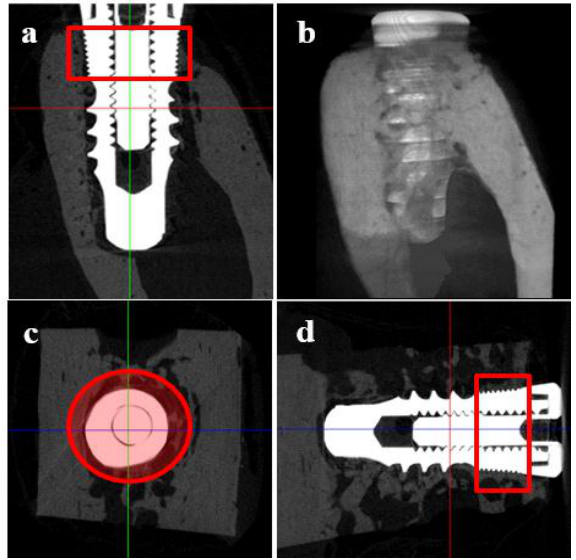
Figure 2. Micro-computed tomography (μCT) images in each group. ( a ) Buccolingual section image; ( b ) three-dimensional (3D) image; ( c ) Horizontal section image; and ( d ) Mesiodistal section image. Region of interest (ROI) was defined as an annular area of thickness 1 mm surrounding the defect area (red circle) in the marginal portion of the peri-implant from the first microthread to the last microthread. Bone volumes were measured in this ROI.